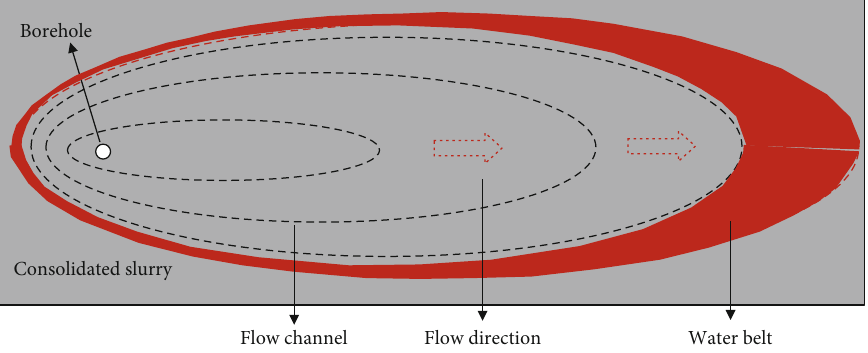
Figure 12: Schematic of slurry fl ow rule.